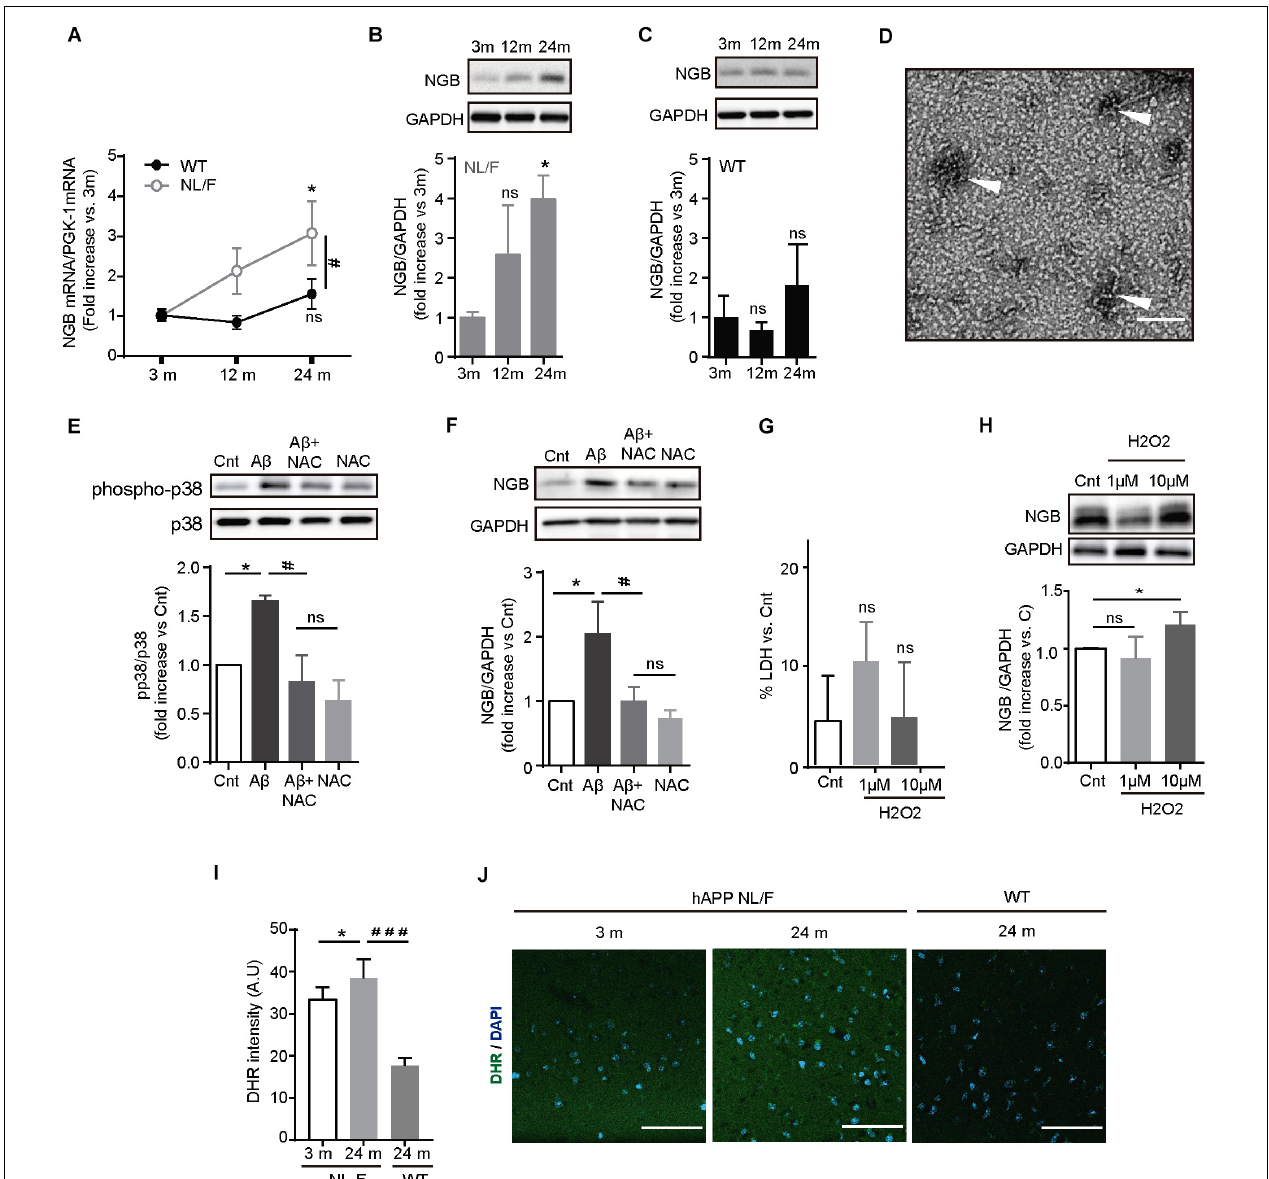
FIGURE 3 | Ngb expression is enhanced in the cerebral cortex of old APP NL/F mice. (A) Ngb mRNA levels quantified in the cerebral cortex by qRT-PCR increase over aging only in hAPP NL/F mice. ( n = 4 mice per genotype; * p < 0.05 vs. 3 months, # p < 0.05 vs. WT). (B,C) Ngb protein levels determined in the cerebral cortex by western blot increase in old hAPP NL/F (B) mice but not in WT (C) (of note: antibody specificity was tested by shRNA knockdown and by over-expression: Figure 1 for Reviewer 1). Plots show quantification of western blot experiments ( n = 4 mice per age; * p < 0.05, ns: not significant, vs. 3 months). (D) Electron microscopy image of A β 42 (scale bar = 100 nm). In order to obtain A β 42 oligomers, synthetic human A β 42 monomers were diluted in DMEM and incubated overnight at 4 ◦ C. Oligomers are pointed out by arrowheads. (E) Western blot showing the activation in 14 DIV primary neurons of p38 (phospho Tyr 180/Thr 182) after 24 h treatment with 5 µ M A β 42 oligomers [prepared like in Panel (D) ] and its decrease with pre-treatment with 2 mM NAC ( n = 6; bars represent the mean ± SEM; * p < 0.05, # p < 0.05, ns:not significant). (F) 5 µ M A β 42 oligomers trigger the expression of Ngb in primary cortical neurons and it is reverted by 2 mM NAC. A plot with the quantification of Ngb for the different conditions is shown ( n = 6; * p < 0.05, # p < 0.05, ns: not significant). (G) Plot showing the toxicity of H 2 O 2 treatment in cortical neurons determined by LDH release ( n = 4; * p < 0.05 vs. vehicle (Cnt), ns: not significant). (H) 10 µ M H 2 O 2 treatment induces the expression of Ngb protein in cortical neurons determined by western blot. The plot shows the quantification of 4 independent western blot experiments (* p < 0.05, ns: not significant). (I) Analysis of the ROS labeling with DHR in cortical slices of hAPP NL/F mice, and WT mice ( n = 12 slices from 3 mice of old WT and hAPP NL/F and 5 slices from 2 mice of young hAPP NL/F; * p < 0.05, ### p < 0.001). (J) Representative confocal images of hAPP NL/F mice of 3 and 24 months, and WT mice of 24 months, labeled against ROS with DHR. Scale bar: 50 µ m. Statistical significance was analyzed by two-way (panel A ) or one-way [panels (B,C) and (E–I) ] ANOVA, without interaction, followed by Tukey post hoc analysis. Bars represent the mean ± SEM. (3 m, 12 m, 24 m means 3 months, 12 months, and 24 months, respectively).